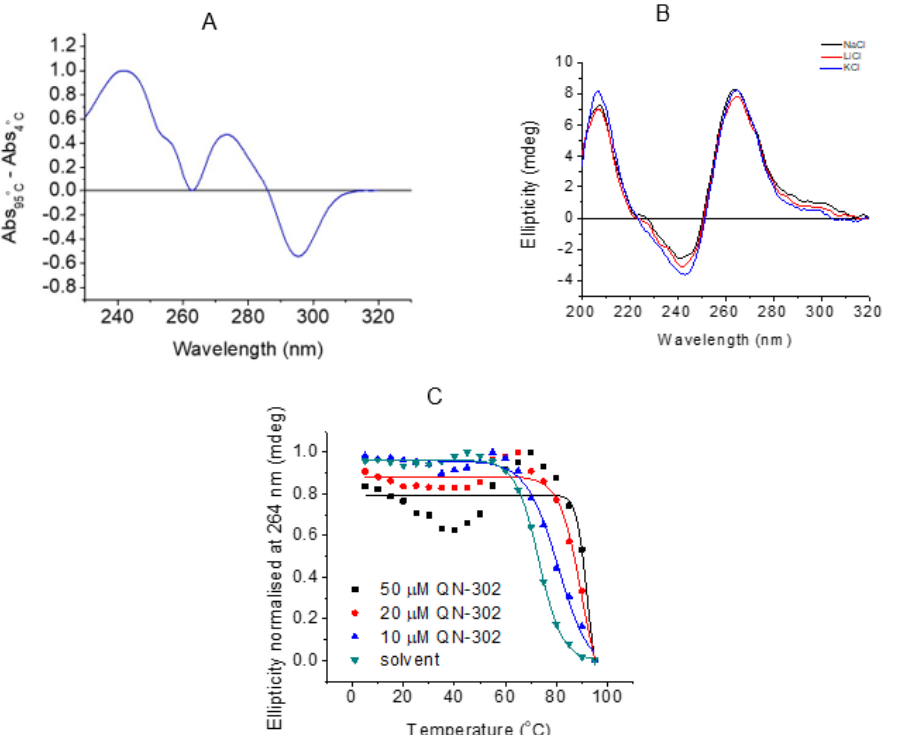
Figure 5. ( A ) Thermal difference spectra of 5 µM S100P PQS in 10 mM lithium cacodylate, 100 mM KCl buffer at pH 7.0. ( B ) CD spectra of 10 µM S100P quadruplex sequence (Figure 1B) in 10 mM lithium cacodylate, pH 7.0 and 100 mM of either KCl, NaCl or LiCl, as indicated. ( C ) Representative CD melting experiments with10 µM S100P quadruplex in 10 mM lithium cacodylate, pH 7.0, 100 mM KCl and 0, 10, 20 or 50 µM QN-302 as indicated.